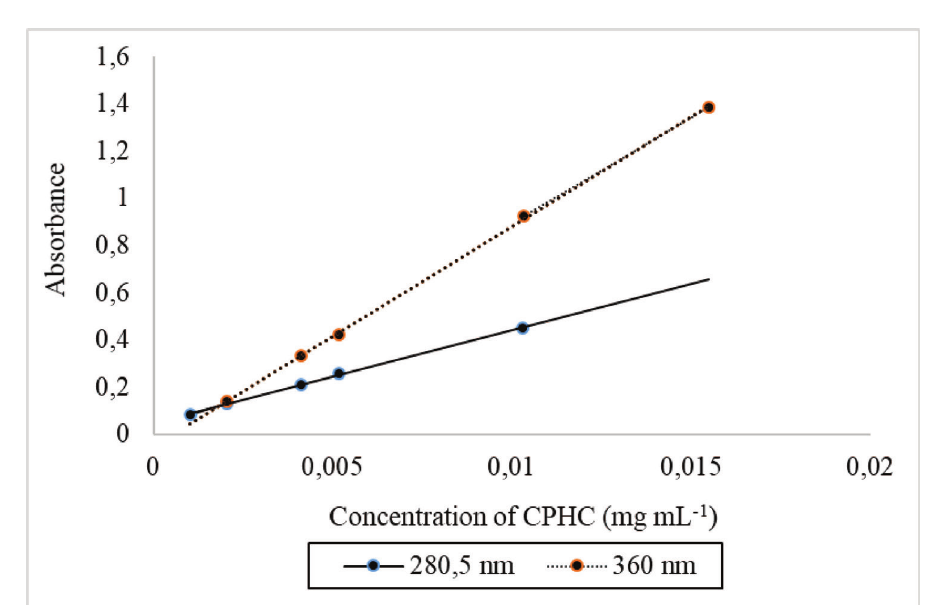
FIGURE 4 - Calibration curves of